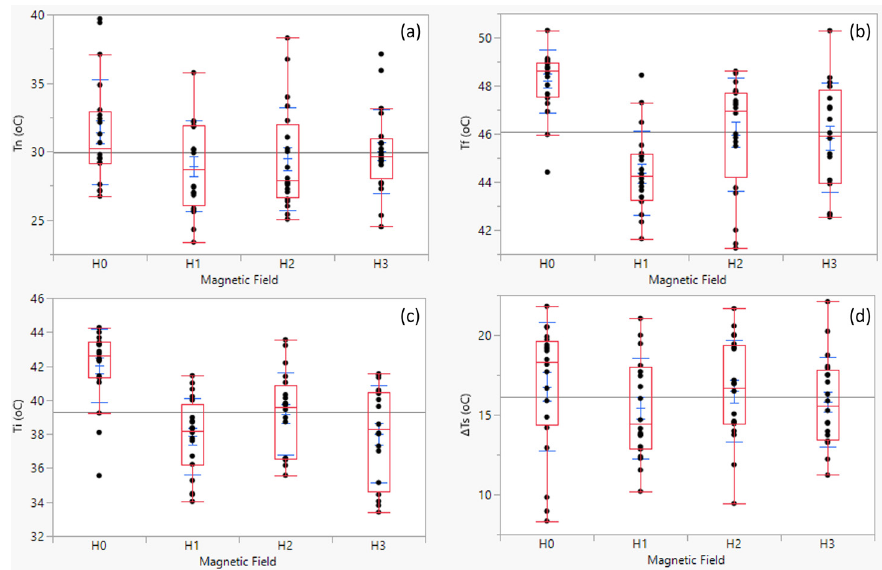
Figure 3. Individual data and statistical analysis of the temperature parameters for freezing of CoNHH as a function of magnetic field intensities: (a) nucleation temperature ( T